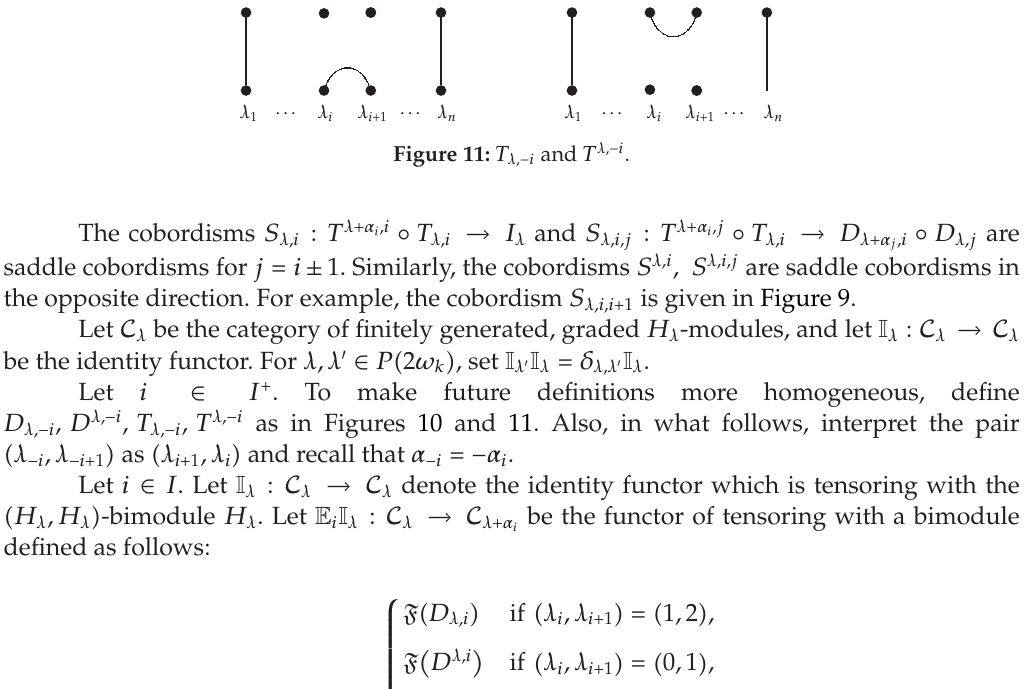
Figure 10: D λ, − i and D λ, − i .